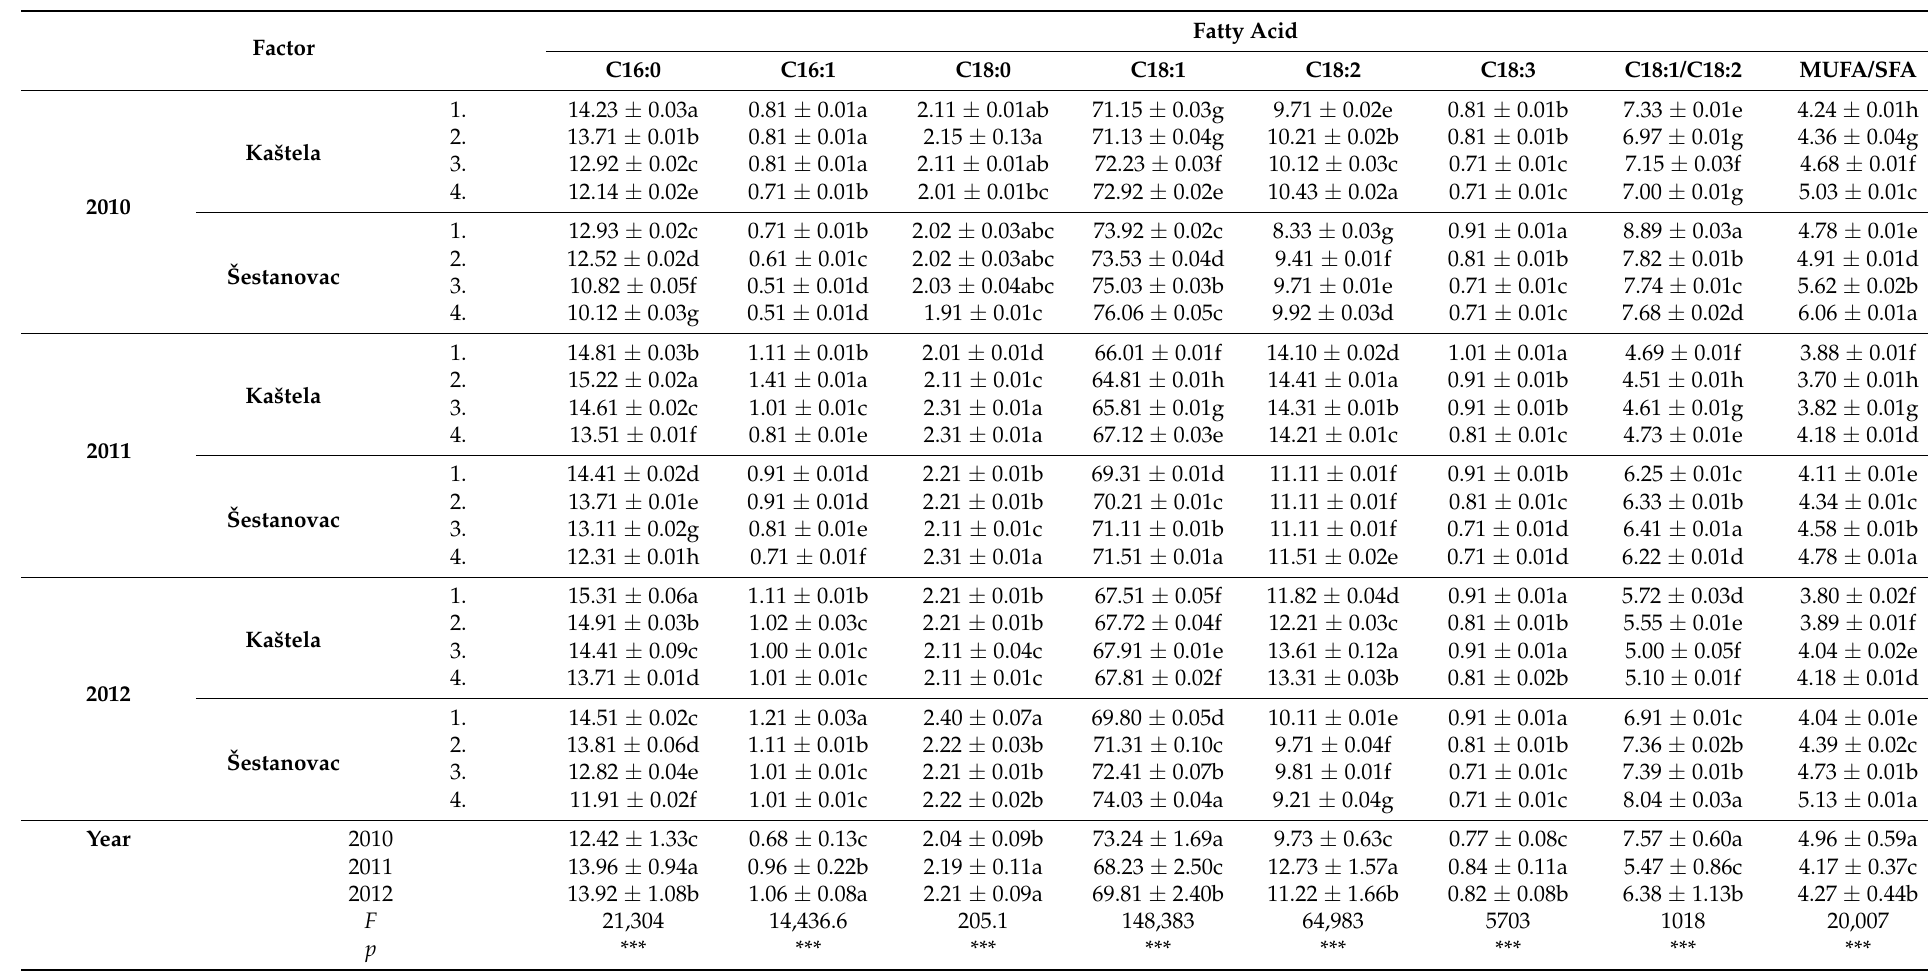
Table 3. Fatty acid composition of Oblica virgin olive oils during ripening obtained from 2 distinct olive orchards (Kaštela and Šestanovac) in 3 successive crop